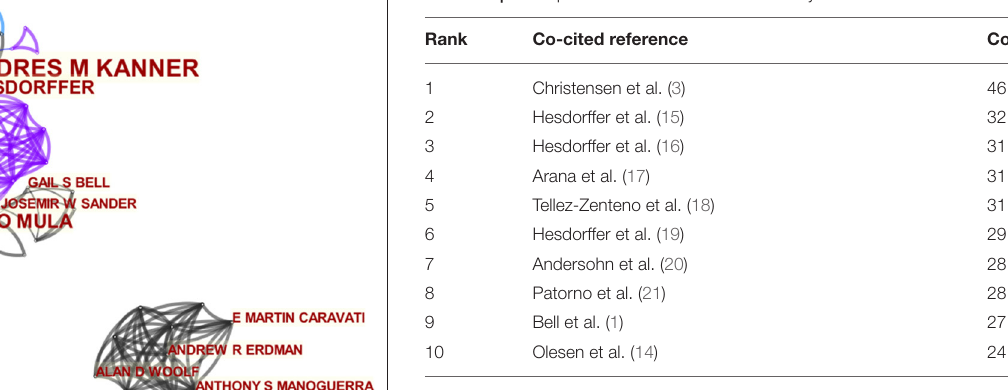
TABLE 3 | The top 10 co-cited references sorted by the number of